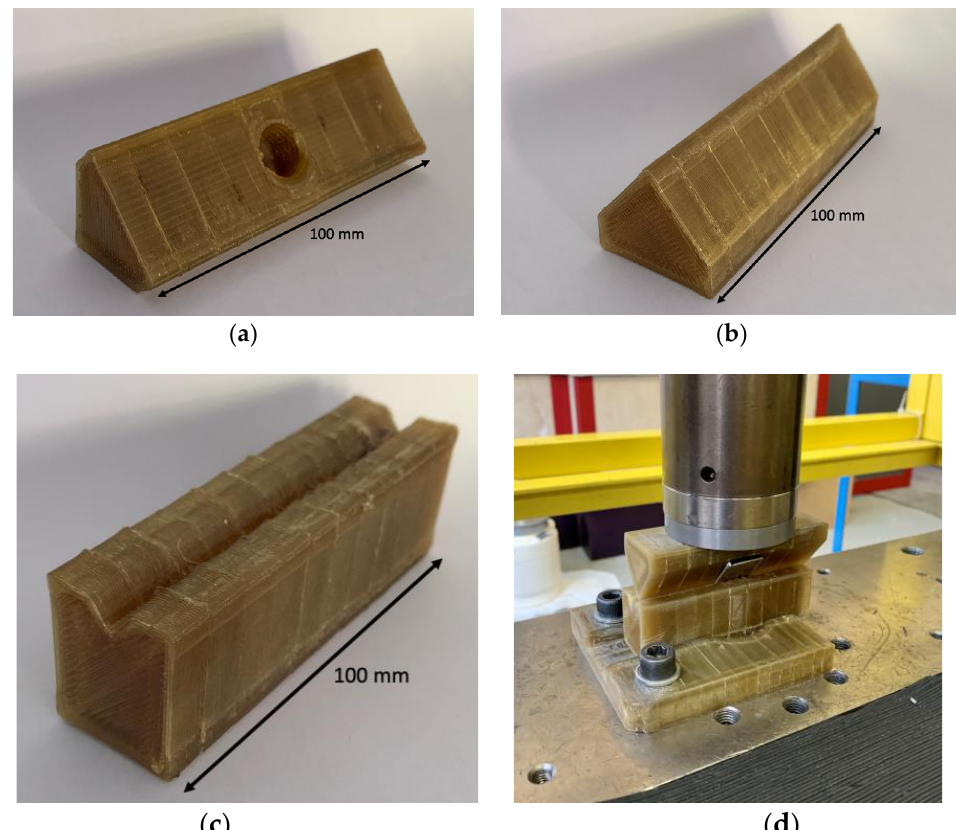
Figure 12. 3D printed punch after removal of burrs with pliers; in ( a ) the side of the punch which is connected to the machine ram is shown; in ( b ) the active side of the punch is shown; 3D printed die ( c ), complete 3D printed tooling set ( d ) after post-processing with sandpaper and Dremel, mounted on the MTS machine (the bent sheet metal is also shown).